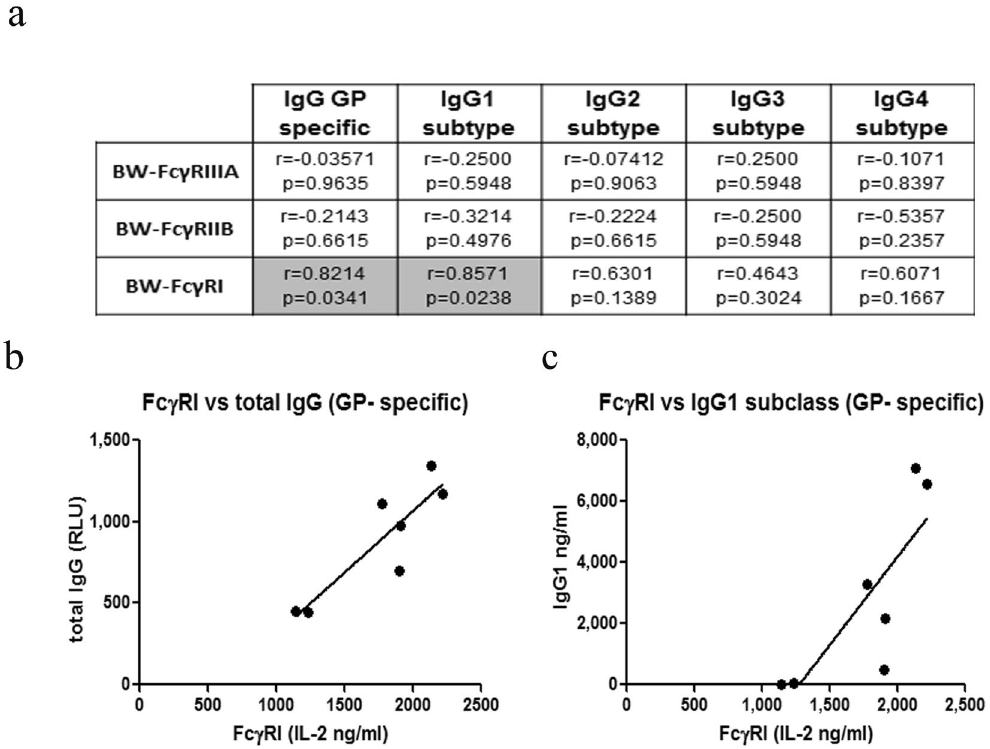
Figure 6. Correlation of reporters’ response and IgG levels. ( a ) Spearman rank-order correlation coefficients table for associations between reporters’ response and IgG subclasses is depicted in the 15 cells representing the tabulations. Each cell contains the corresponding spearman r-value and the probability of the association. The two grey-shaded cells have statistically significant associations, whereas the 13 clear cells have non-significant associations. ( b , c ) Spearman regression analysis for Fc γ RI and total IgG ( b )/IgG1 subclass ( c